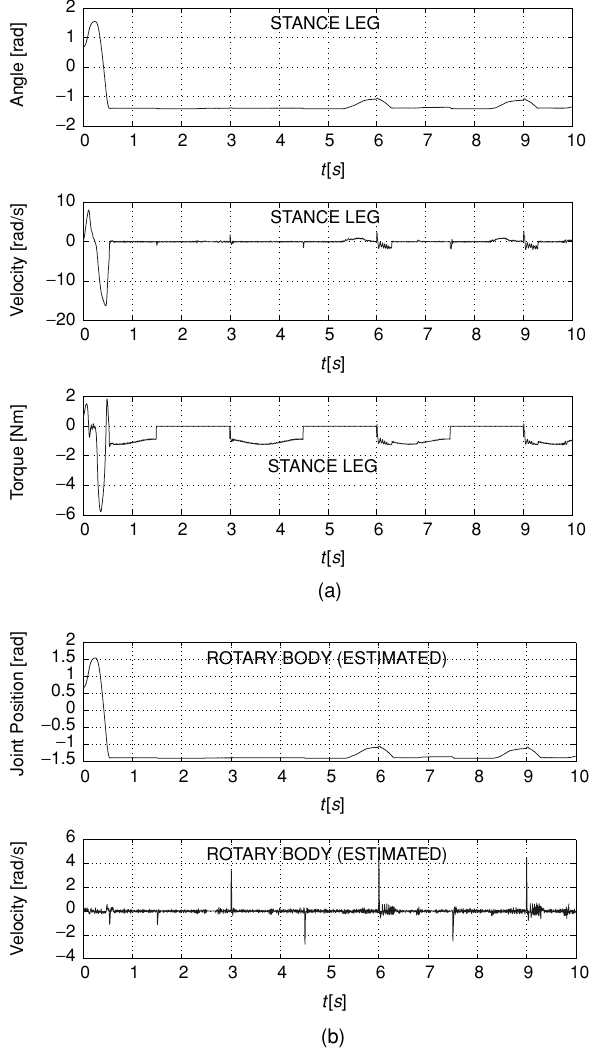
Figure 7 Experimental results for Te = 10 s. (a) States response for stance leg. (b) States response for central